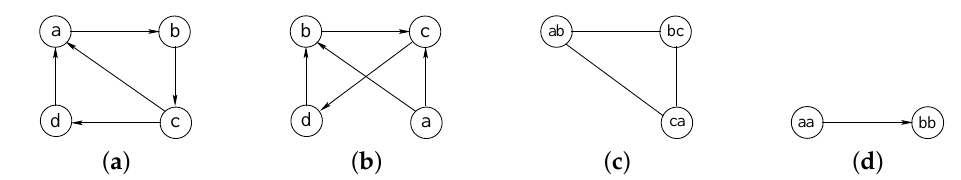
Figure 3. A running example. The graphs G and H , of ( a ) and ( b ), produce the MCS of ( c ) if they are considered undirected and unlabeled, and the MCS of ( d ) if they are considered as directed and